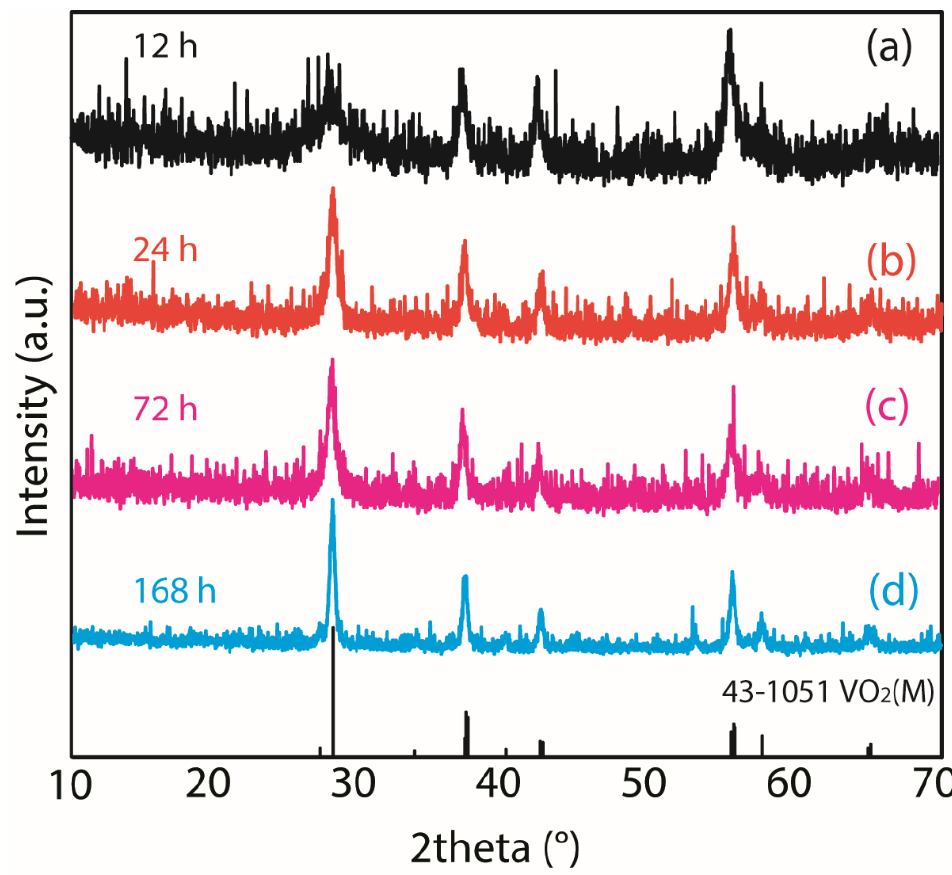
Figure 3. ( a – d ) XRD patterns of hydrothermal samples with different duration at 260 °C with 60 μL N 2 H 4 ·H 2 O. N · H 2 H 4 2